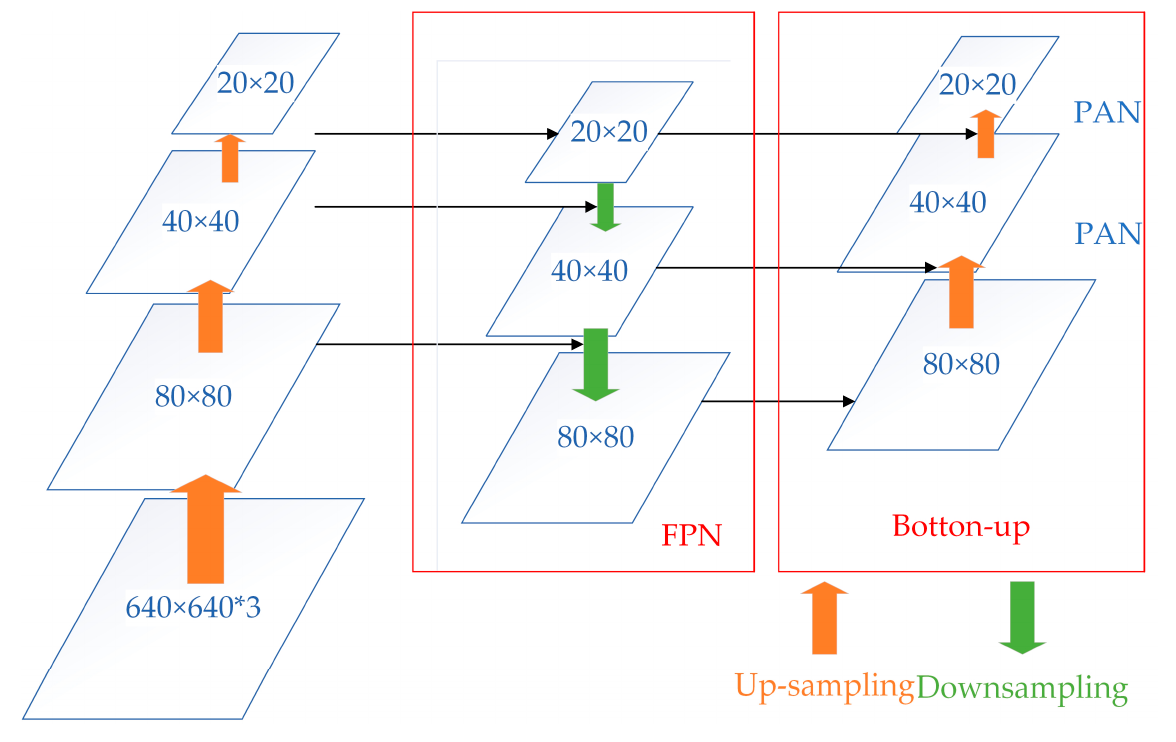
Figure 9. FPN+PAN structure.